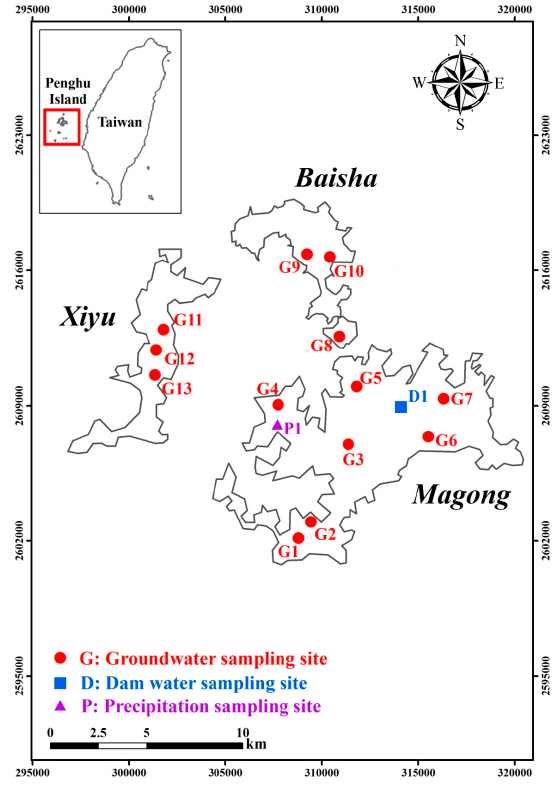
Figure 1. Locations of sampling sites in the study region.